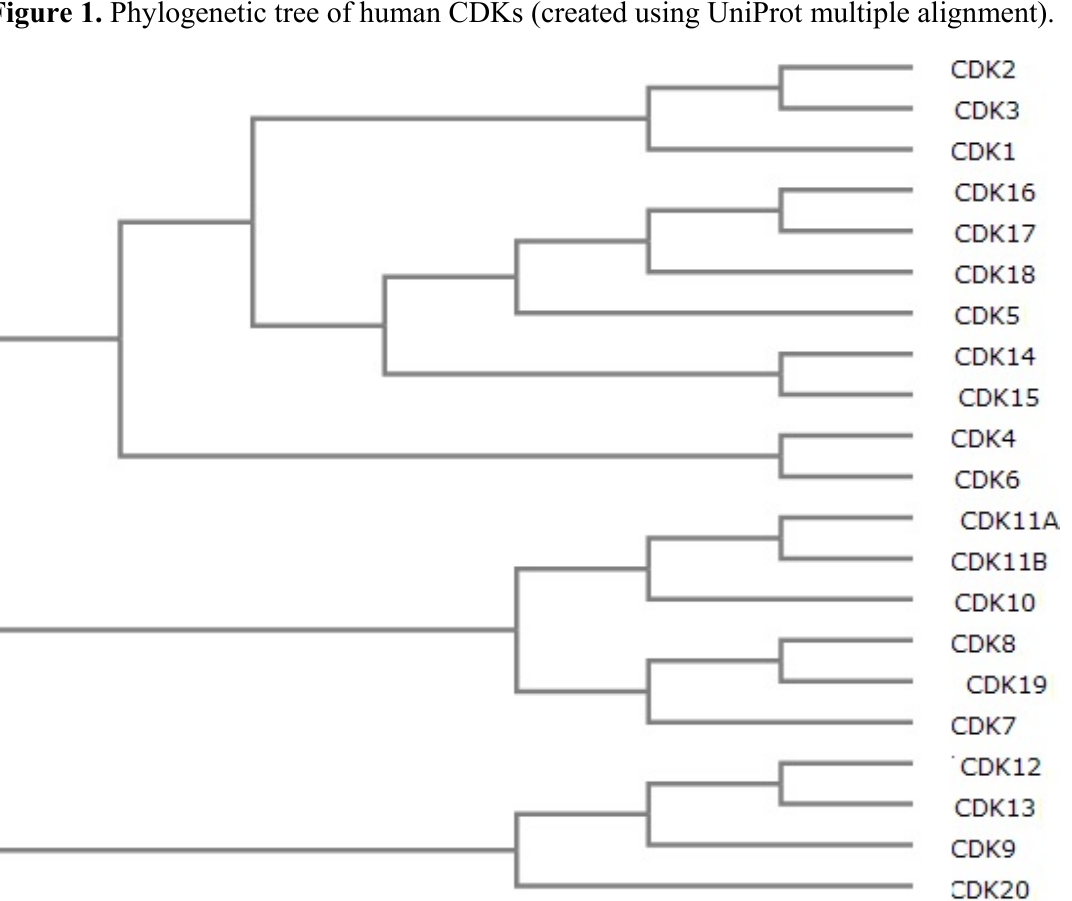
Figure 1. Phylogenetic tree of human CDKs (created using UniProt multiple